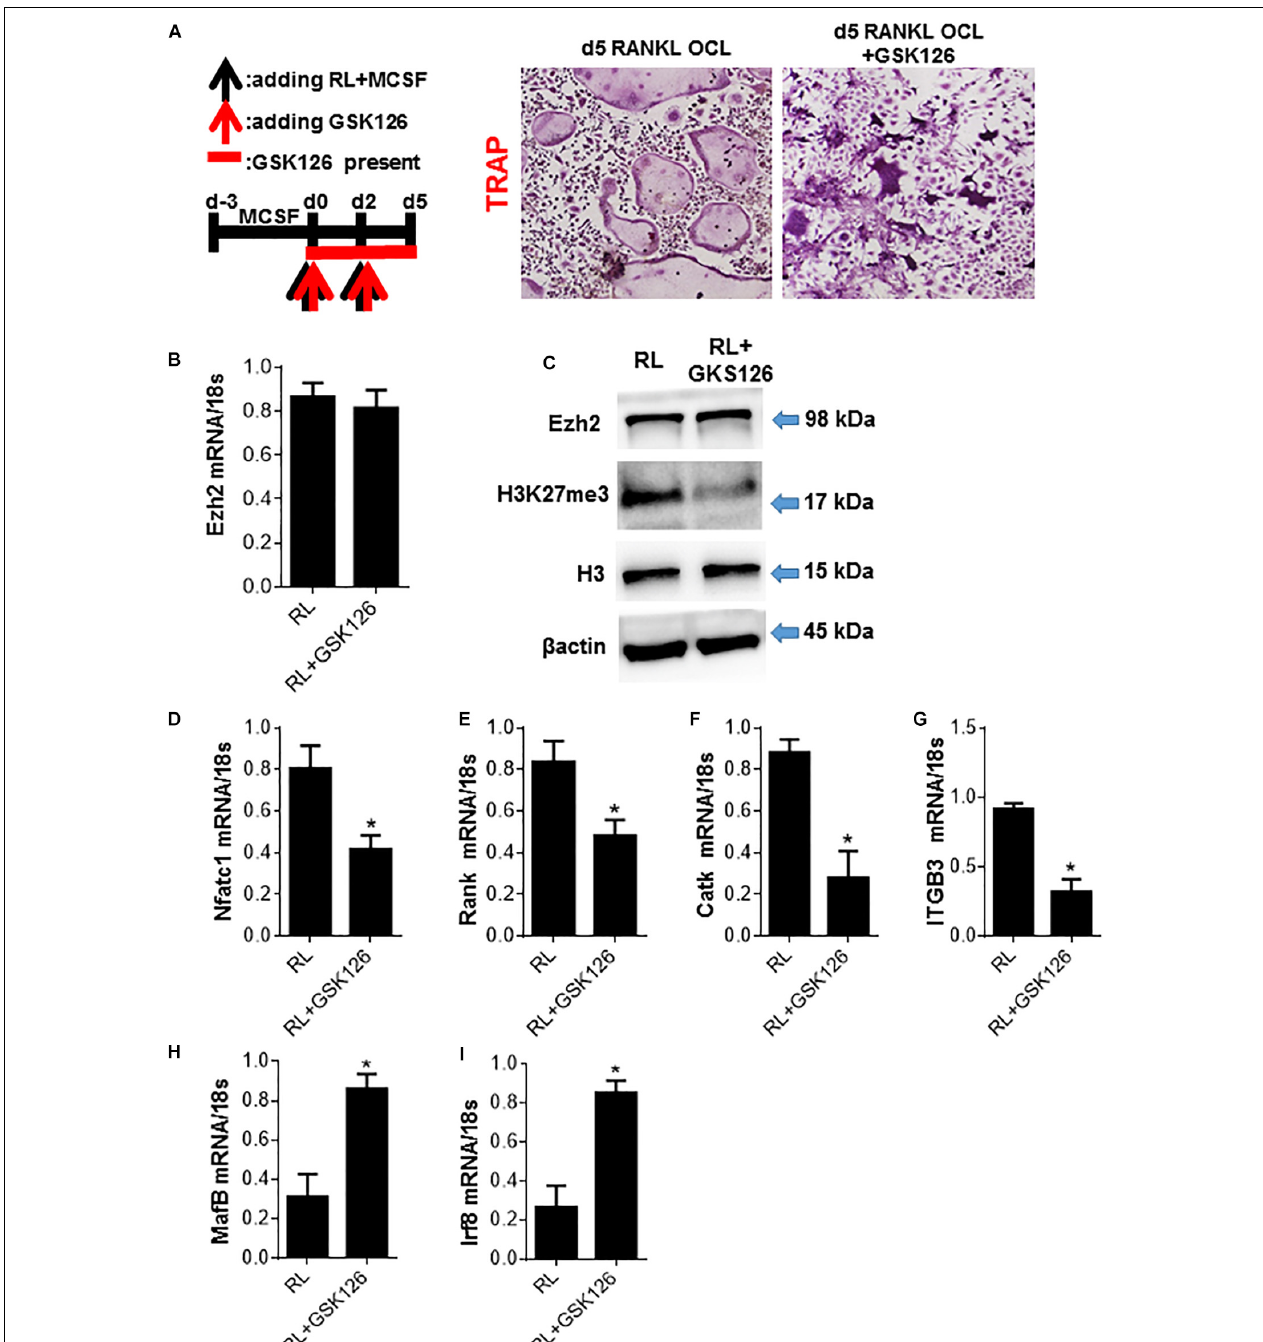
FIGURE 4 | Ezh2 plays a critical role in osteoclastogenesis by activating osteoclast regulators and repress the osteoclast inhibitory factors. BMMs were cultured with MCSF for 3 days (days 3 to 0) to form OCL precursors (OCLp) before addition of RANKL/MCSF at day 0 to generate OCL. (A) OCLp were cultured with RANKL/MCSF in the presence of the indicated concentrations of GSK126 for 5 days. TRAP+ OCL formed were analyzed by microscopy (representative images on left) and the counts for multinucleated ( n ≥ 3) TRAP+ OCL/well graphed (right). GSK126 (10 µ M) was added at the indicated time intervals during the processes of OCLp and OCL (day 4) formation, and representative images and counts for multinucleated ( n ≥ 3) TRAP+ OCL/well are shown. (B) OCLp (day 0) or stimulated with RANKL/MCSF ± GSK126 (10 µ M; GSK) for 5 days were analyzed for Ezh2 mRNA by quantitative PCR (qPCR). (C) OCLp cultures (day 0) or after stimulation with RANKL/MCSF ± GSK126 (10 µ M) for 1 day were analyzed for total cellular levels of Ezh2, H3K27me3, H3, and β -actin by WB. (D–G) OCLp (day 0) or after stimulation with RANKL/MCSF ± GSK126 (10 µ M) for 5 days were analyzed for the expression of OCL-specific genes NFATc1, RANK, CatK, ITGB3 by qPCR. (H,I) OCLp (day 0) or after stimulation with RANKL/MCSF ± GSK126 (10 µ M) for 1 day were analyzed for the expression of OCL-negative regulators MafB and Irf8 by qPCR. WB analyses show representative of three independent experiments and error bars in mRNA experiments represent SEM for 4 biological replicates. * p < 0.05.